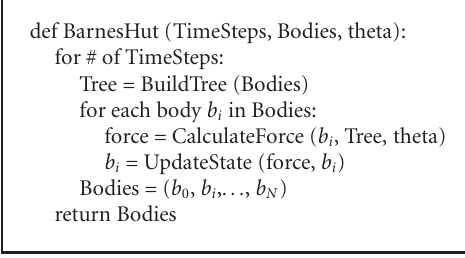
Algorithm 1: Pseudocode of software Barnes-Hut implementa- tion.